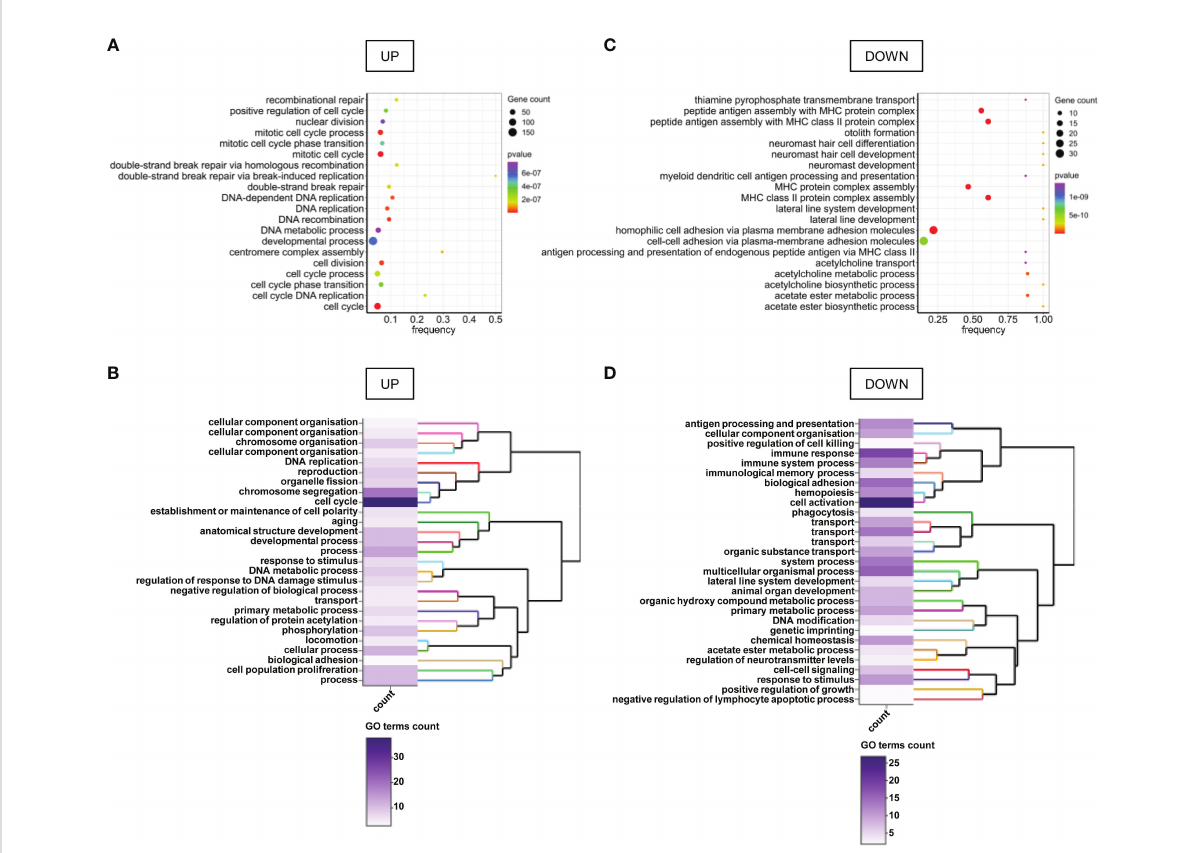
FIGURE 2 GO terms enriched in genes differentially expressed between FHIT low /pHER2 high and other tumors. (A, C) Bubble charts of the top 20 enriched GO terms for genes up-regulated (A) and down-regulated (C) in FHIT low /pHER2 high tumors versus others. Genes are annotated in GO terms with ViSEAGO R package using the Ensembl data base. The horizontal axis represents the frequency of differentially expressed genes in the ontology, i.e. the number of up- or down-regulated genes annotated to the speci fi c ontology divided by the total number of genes in the ontology. The size of the bubble represents the number of genes up- or down-regulated annotated to the ontology and the color depends on the p-value of Fisher ’ s exact enrichment test. (B, D) Heatmap and clustering of the GO clusters for GO terms enriched in genes up- (B) or down-regulated (D) in FHIT low /pHER2 high tumors versus others. Clustering was performed on the semantic similarity. The color of the heatmap depends on the number of GO terms in the